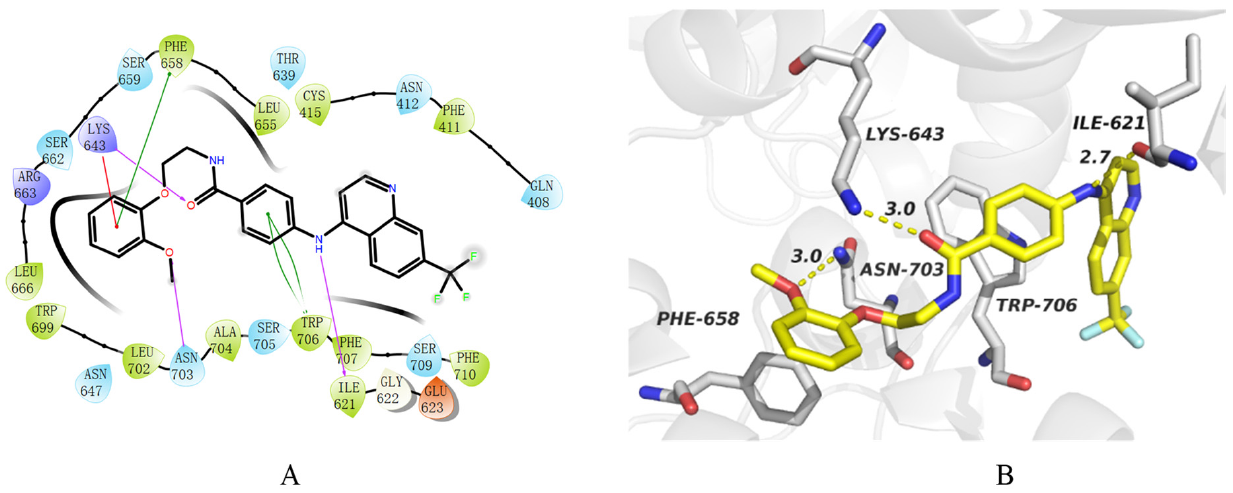
Figure 5. Docking model of G07 in the active site of RNA polymerase (PDB ID: 3CM8). ( A ) Two- dimensional (2D) diagrams of G07 − 3CM8 interactions. The hydrogen-bond interactions with residues were represented by a purple dashed arrow directed towards the electron donor. The Pi- Pi stacking interactions with residues were represented by the green line segment. The Pi-cation interactions with residues were represented by the red line. ( B ) Three-dimensional (3D) diagrams of G07 − 3CM8 interactions. The hydrogen-bond interactions with residues were represented by a yellow dashed line.